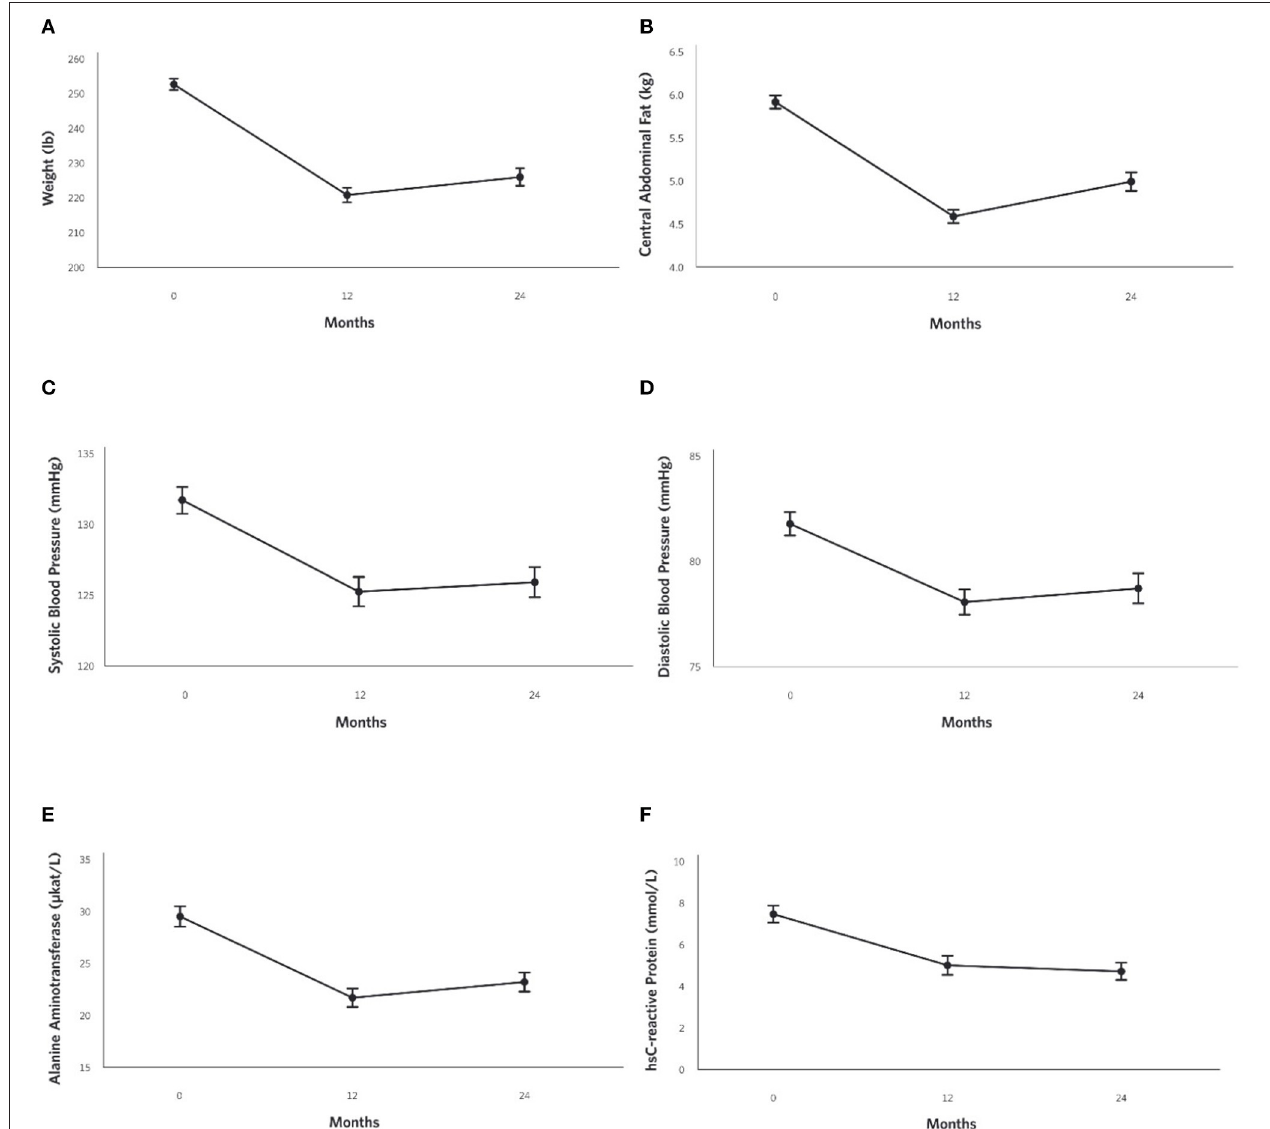
FIGURE 4 | Adjusted mean changes from baseline to 2-years in the CCI group for (A) Weight ( − 10% relative to baseline, P = 8.8 × 10 − 28 ), (B) Central Abdominal Fat [CAF] ( − 15% relative to baseline, P = 1.6 × 10 − 21 ), (C) Systolic Blood Pressure ( − 4% relative to baseline, P = 2.4 × 10 − 6 ), (D) Diastolic Blood Pressure ( − 4% relative to baseline, P = 3.3 × 10 − 5 ) (E) Alanine aminotransferase [ALT] ( − 21% relative to baseline, P = 4.0 × 10 − 10 ), and (F) High sensitive C-reactive protein [hsCRP]( − 37% relative to baseline, P = 6.9 × 10 − 13